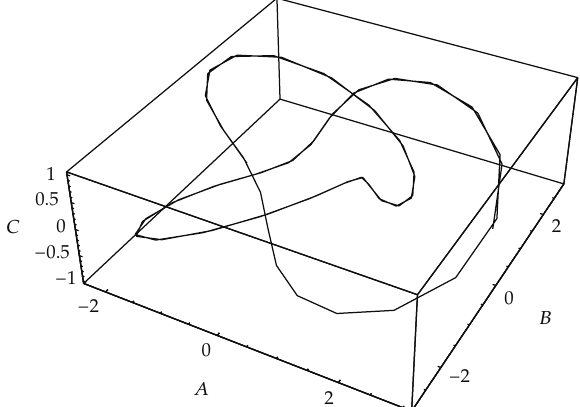
Figure 8: The knotted closed curve corresponding to the solution (cid:2) 3.14 (cid:3) with (cid:2) 3.4 (cid:3) , t ∈ (cid:4) 0 , 4 π (cid:5) , k (cid:6) 1 /